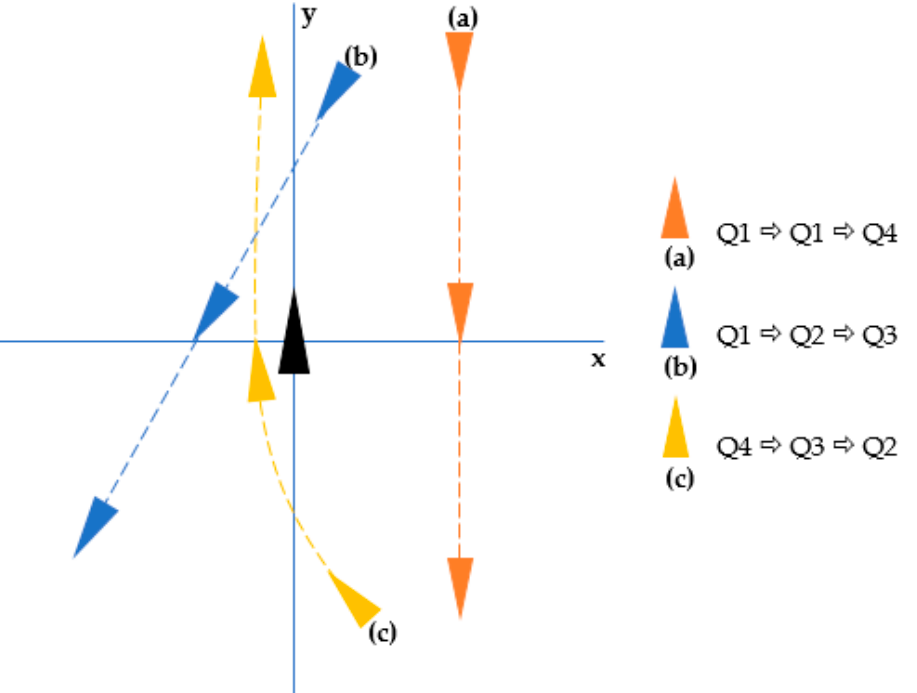
Figure 6. Concept of feature extraction: ( a ) relative bearing change (Q1-Q1-Q4), ( b ) relative bearing change (Q1-Q2-Q3), ( c ) relative bearing change (Q4-Q3-Q2).